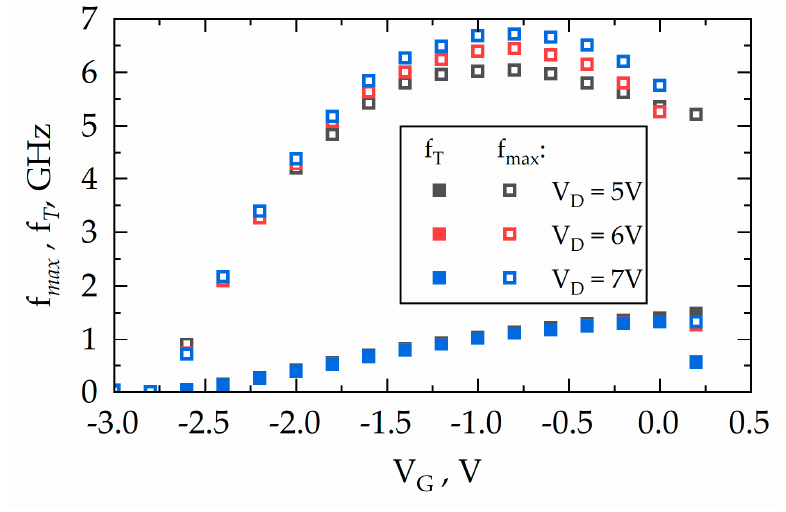
Figure 10. Frequencies f T and f max at different biasing conditions extracted from S-parameters measurements of RF T-HEMT-1 with W Ch = 0.4 mm and L G = 5 μ m.